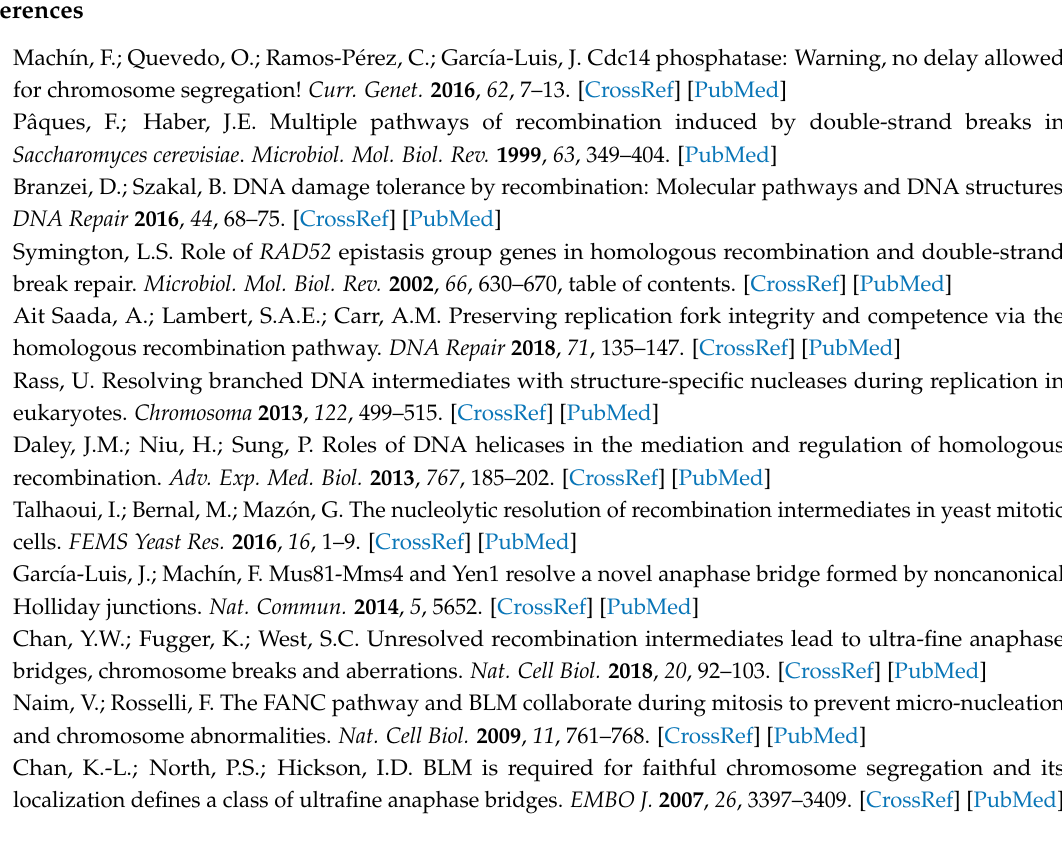
Figure S1: Completion of chromosome segregation under low exogenous replication stress for the helicase mutants included in this